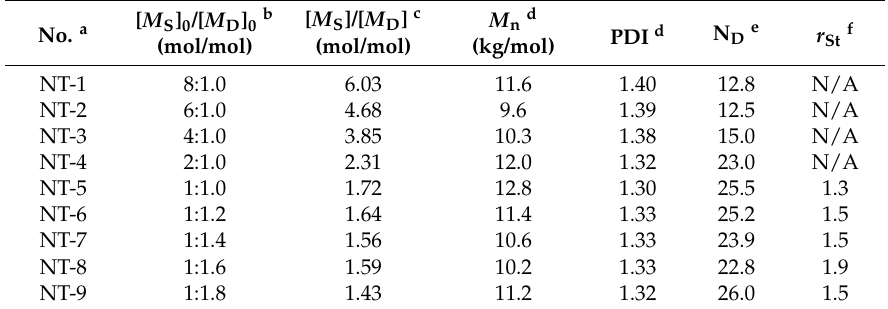
Table 1. Composition, structures and reactive ratios for copolymers of styrene and DPE-SiOEt in the absence of additives.